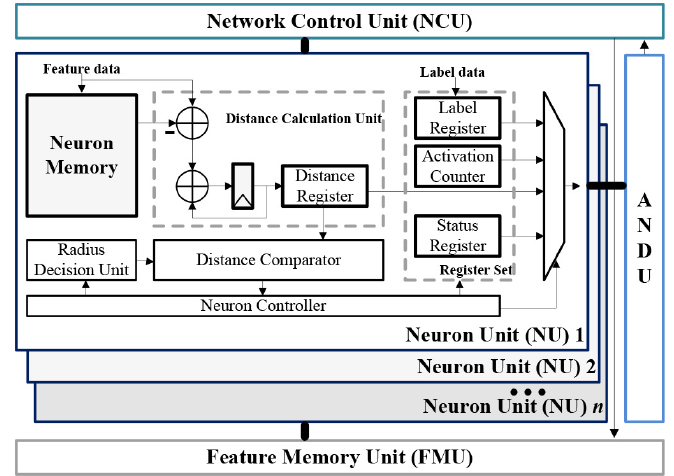
Figure 6. Block diagram of the proposed RCE-neural network (NN) processor.